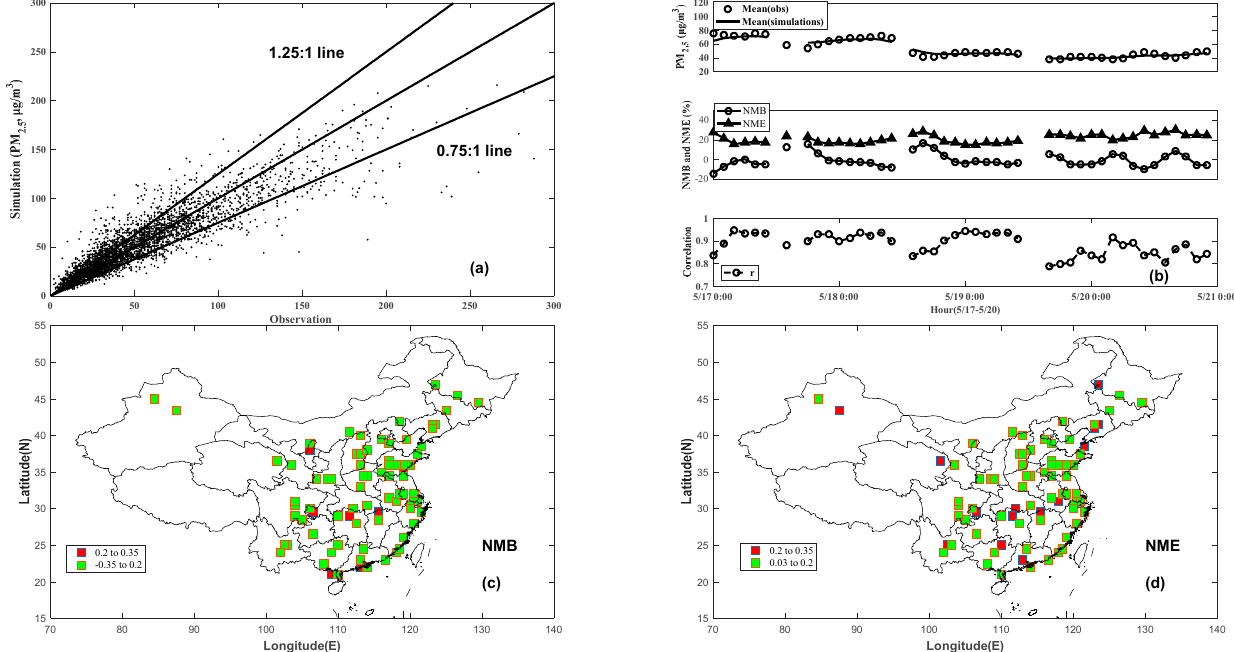
Figure 7. Comparison of the simulated and observed PM 2.5 concentrations on 17–20 May 2014: ( a ) Scatter plot ( µ g/m 3 ) (the 1:2, 1:1 and 2:1 lines are shown for reference), ( b ) Variation of spatial mean, NMB, NME and correlation (r), and spatial distribution of ( c ) NMB and ( d ) NME. To sum up, the DCIM provided effective dynamic information compared with kriging and COPF. First, the time series analysis of the simulation values using mean, NMB, NME and correlation coefficients showed that the DCIM can achieve a more ac- curate real-time simulation, which the dynamically unconstrained interpolation tech- niques were unable to achieve. Second, the DCIM can also give the characteristics of the spatiotemporal variation parameters during the target simulation periods, which con- tributed to the existing relevant research in China to a certain extent. 3.3. Mapping of the Mean PM 2.5 Simulations The mean observations of the 80 sample cities and mean distributions of PM 2.5 on 8–11 November 2014 were mapped in Figure 8. The mean distributions of DCIM, kriging and COPF showed similar distribution with the mean observations map. The DCIM re- sults presented a smoother pattern with a smaller MAGE than the results from the other methods did. As can be seen from the DCIM results, the levels of PM 2.5 simulations were higher in the northern region than in the southern. Shandong and Jiangsu provinces presented higher PM 2.5 concentrations, which was in conformity with industrial devel- opment. Guangdong and Fujian provinces presented lower PM 2.5 concentrations due to the low levels of anthropogenic emissions and favorable meteorological conditions for atmospheric dispersion [10]. Meanwhile, heavily polluted regions were identified in North and Northeast China, PM 2.5 concentrations of which rose to 120–160 μ g/m 3 during the target simulation period. Compared with the MODIS-derived seasonal mean 1 km-resolution PM 2.5 maps averaged over the winter period 2000–2018 as shown in [30], the DCIM results showed similar spatial distribution but presented a higher level of PM 2.5 concentrations in Northeast China. One major reason for the higher level might be the serious pollution from coal combustion in winter, as reported in a previous study [26]. Adverse weather conditions (i.e., long, dry winter that require indoor heating) fur- ther intensified the haze epidemic in northern cities. Another reason might be the at- mospheric conditions of aerosols, caused by stagnant weather, with a weak wind and planetary boundary layer [31]. It was noteworthy that air quality in Beijing and Hebei (60–80 μ g/m 3 ) was much improved, which benefited from the introduction of an emer- gency emissions-reduction strategy during the Asia–Pacific Economic Cooperation (APEC) summit in November.